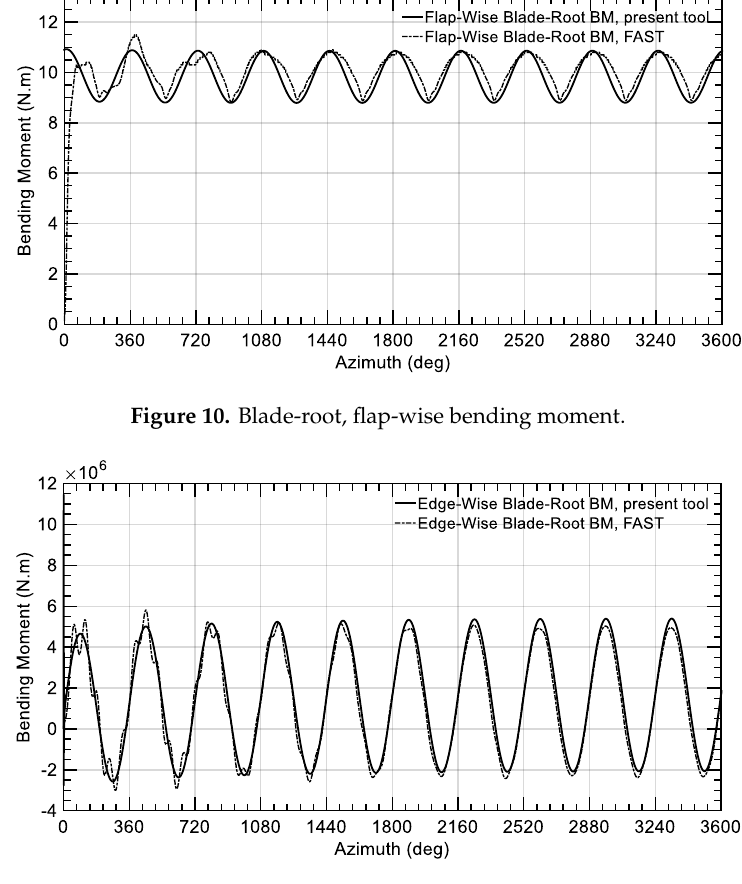
Figure 11. Blade-root, edge-wise bending moment.